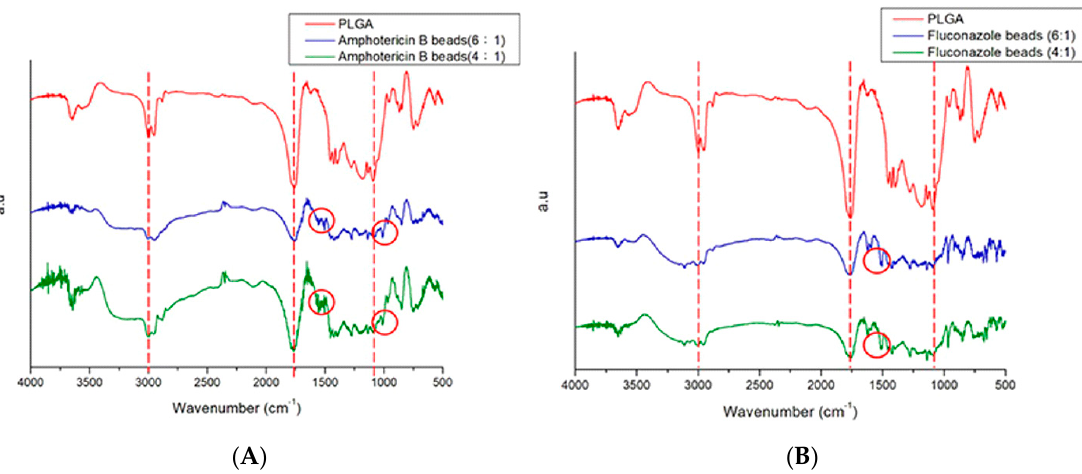
Figure 6. Fourier-transform infrared spectra of ( A ) pure Poly( D , L -lactide- co -glycolide) (PLGA) and amphotericin B/PLGA beads ( B ) pure Poly( D , L -lactide- co -glycolide) (PLGA) and fluconazole/PLGA beads.